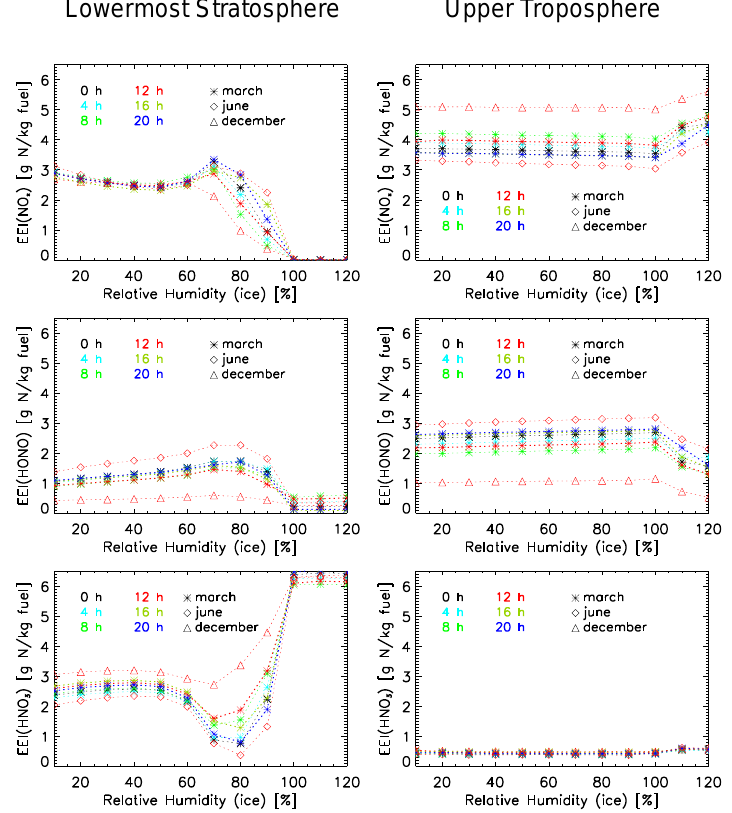
Fig. 17. Plume Transformation Indices for the NAFC ( t l = 46h) as a function of RH ice . Top panel: EEI NO lower panel: EEI HNO . The different colors and symbols show results for different local times and seasons of emission as indicated. Left: 3 emissions into the lowermost stratosphere; right: emissions into the upper troposphere (Meilinger et al., 2005).